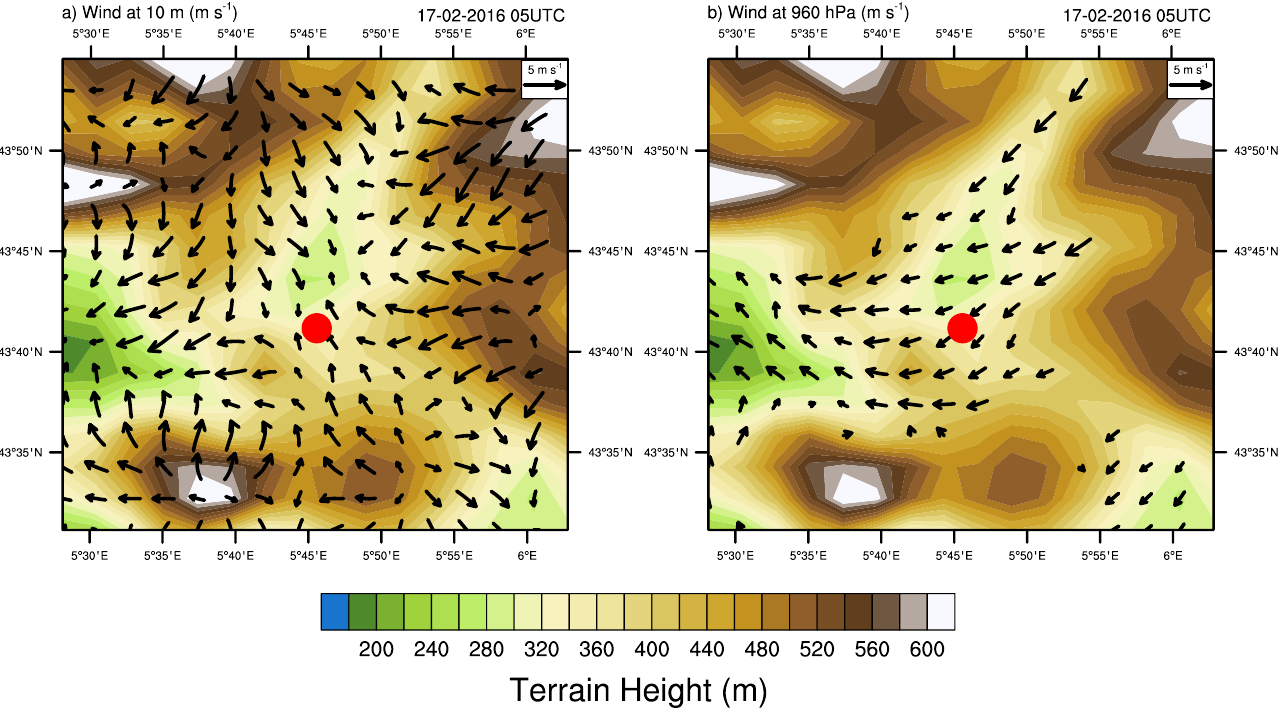
Figure 7. Simulated winds on 15 February 2016 at 00UTC, for a lead time of 41h, corresponding to the forecast at 5UTC on 17 February 2016. ( a ) 10 m winds. ( b ) Winds at the 960hPa pressure level (the forecasted atmospheric pressure at 110m a.g.l. at the MET01 site was 960hPa at this time). WRF topography is represented in color. Table 3. Summary of WRF performance forecasting the 2 m winds at the MET01 site. u and v represent the horizontal wind